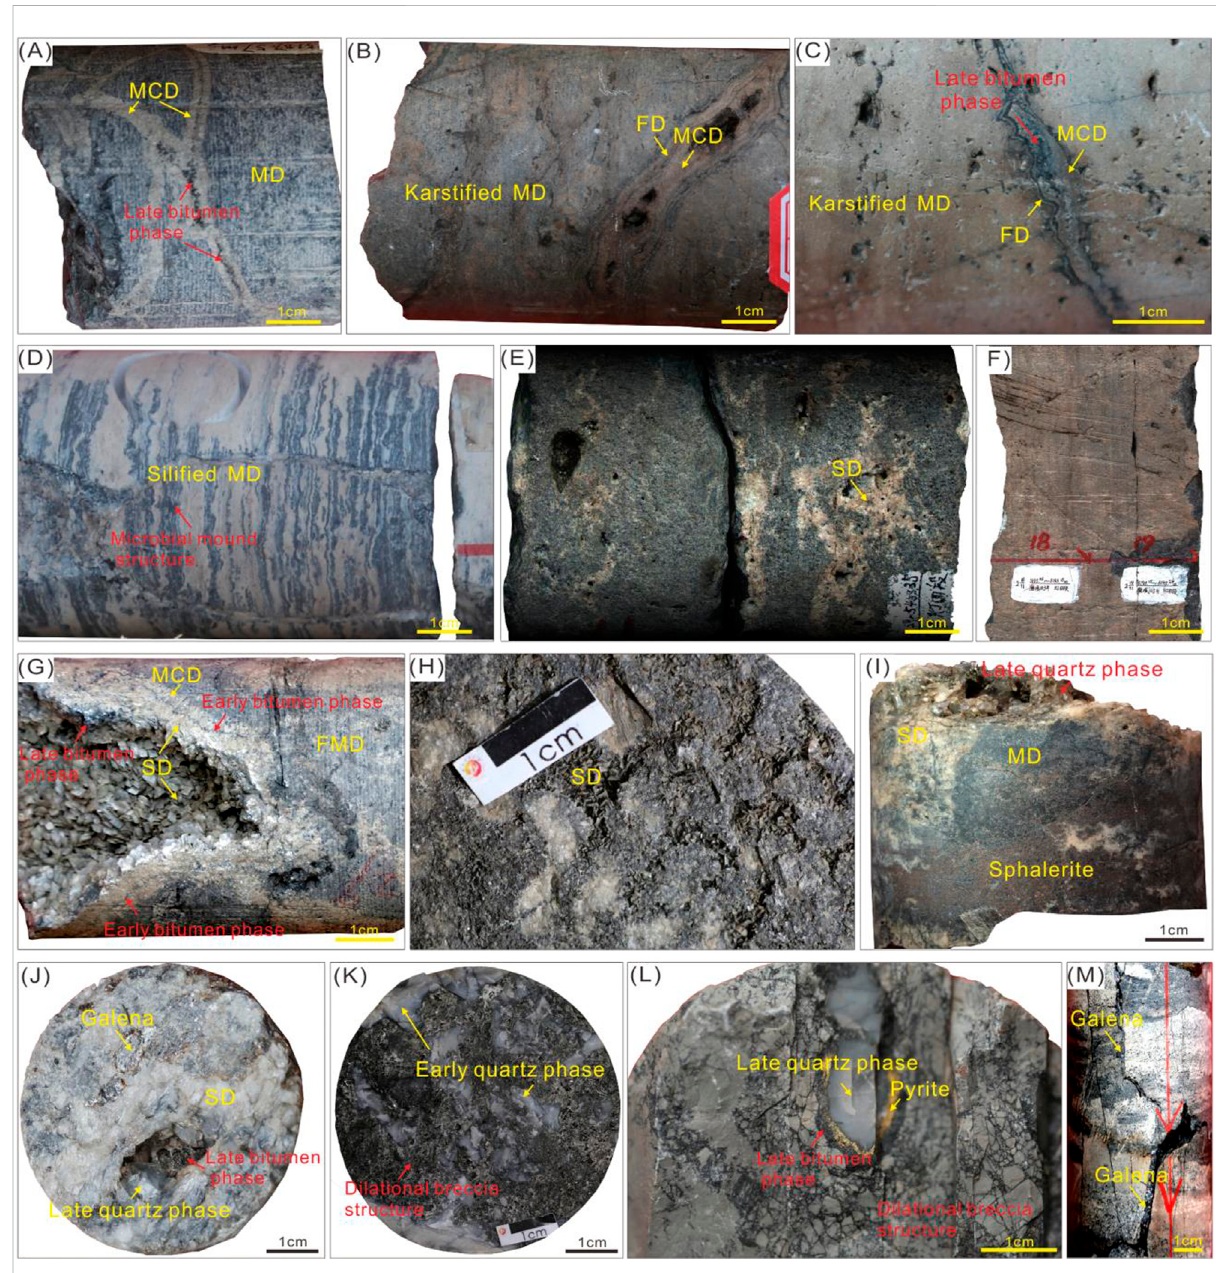
FIGURE 2 Macroscopic characteristics for the Dengying Formation from drilling cores in Central Sichuan Basin. (A) MCD and late bitumen phase fi lled in fractures within the MD, Well GS20, 4th Member, 5187.57 m. (B) FD and MCD fi lled in vugs within karsti fi ed MD, Well GS102, 4th Member, 5085.11 m – 5085.36 m. (C) The original sedimentary structures in the MD have almost disappeared, Well GS7, 4th Member, 5266.49 m – 5266.59 m. (D) The original microbial mound structures are well preserved in sili fi ed MD, Well GS18, 4th Member, 5184.13 m. (E) Scattered intercrystalline pores within FMD, Well GS16, 4th Member, 5453.35 m. (F) Scattered intercrystalline pores within FMD, Well MX103, 4th Member, 5195.24 m. (G) MCD, early bitumen phase and saddle dolomite (SD) coats inner wall of hydrothermal dissolved vug within FMD, Well GS20, 4th Member, 5195.7 m (H) SDwithcurved orlobate crystalfaces fi lledbetweendilationalbreccias, WellMX51,4thMember,5335.7 m (I) SD,sphaleriteandlatequartzphase fi lled in vugs within karsti fi ed MD, Well GS102, 4th Member, 5043.93 m. (J) Mississippi Valley-Type minerals including galena and late quartz phase, Well GS109, 4th Member, 5316.08 m. (K) Early quartz phase fi lled between dilational breccias, Well MX51, 4th Member, 5401.77 m. (L) Pyrite and late quartzphase fi lledinvugswithindilationalbrecciastructure, WellMX39,4thMember,5309.3 m. (M) Galena fi lledinfractureswithinMD,Well GS101, 4th Member, 5517.2